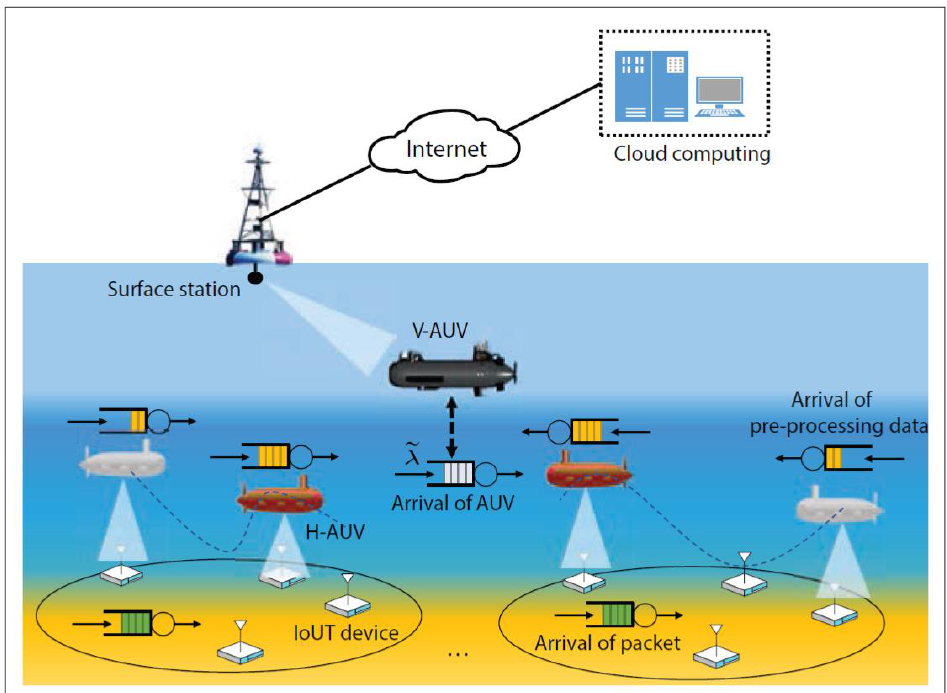
Figure 6. Multiple AUV-aided data collection [35].